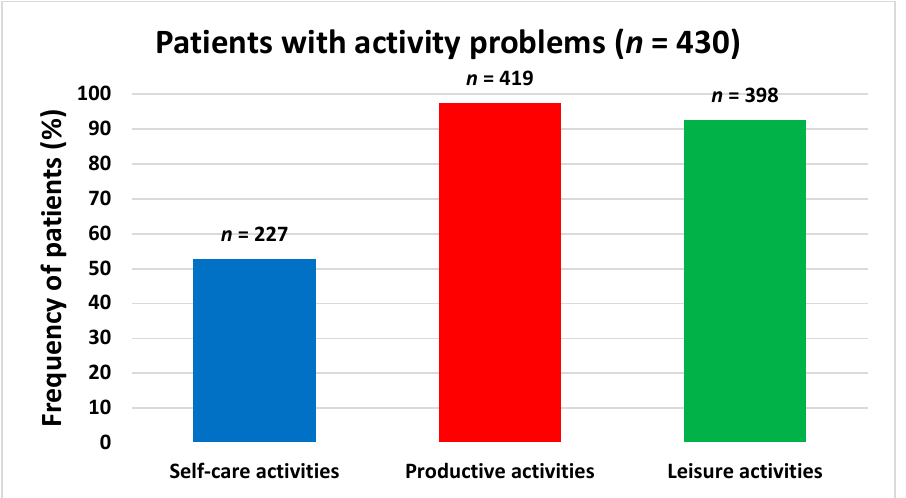
Figure 2. Patients with activity problems within the overall COPM categories: self-care activities (blue), productive activities (red) and leisure activities (green). Frequency ( n ) and relative frequency (%) of patients reported. COPM data is based on 430 patients.